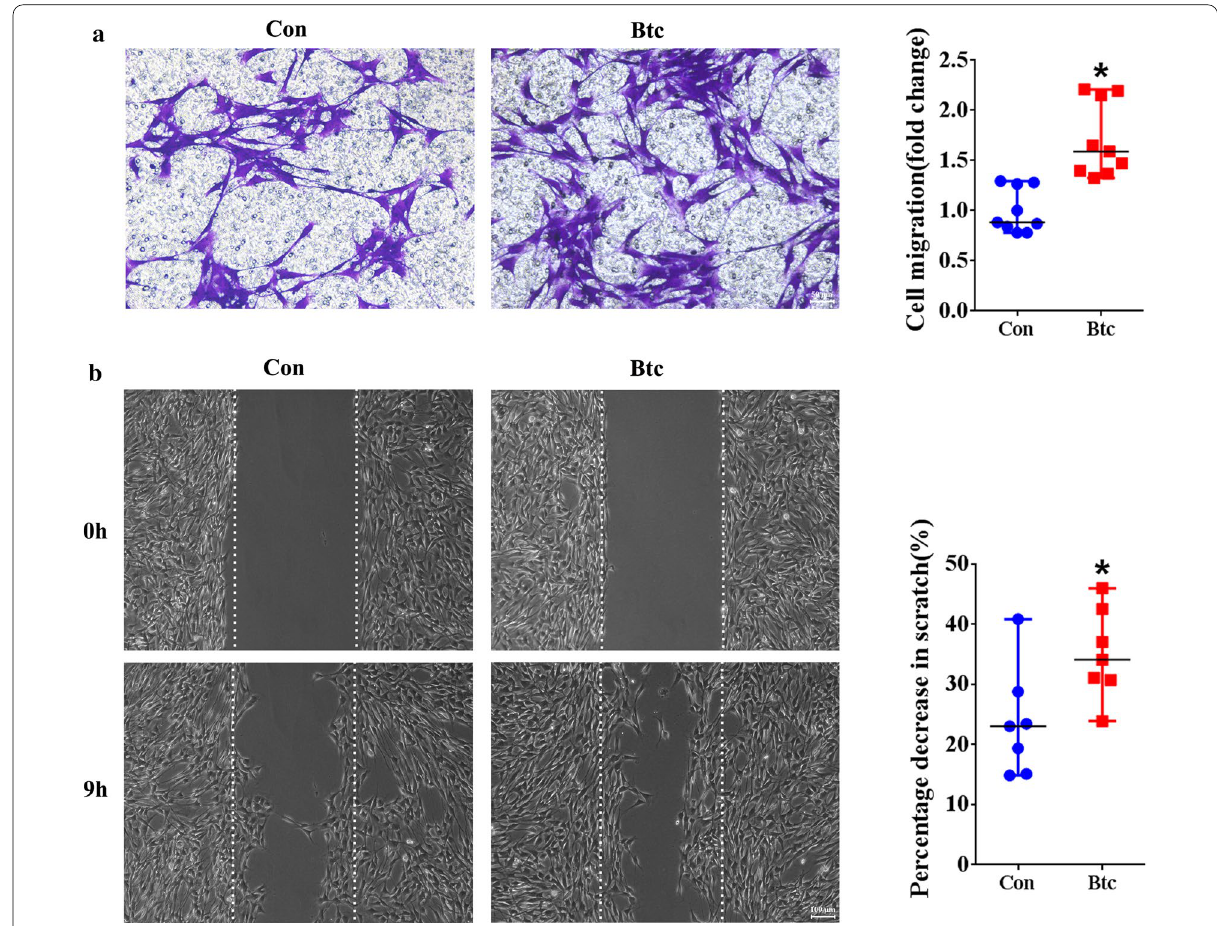
Fig. 3 The in vitro effect of Btc recombinant protein on Schwann cell migration. a Representative Transwell migration images and normalized averaged migration rate of Schwann cells treated with or without Btc recombinant protein. Scale bars represented 50 μm. Transwell migration assay was done three times using duplicate or triplicate wells. Statistical evaluation was performed using Mann–Whitney test. *p-value < 0.05 versus non-treated cells. b Representative wound healing images and percentage decrease in scratch of Schwann cells treated with or without Btc recombinant protein. Scale bars represented 100 μm. Transwell migration assay was done three times using duplicate or triplicate wells. Statistical evaluation was performed using Mann–Whitney test. *p-value < 0.05 versus non-treated